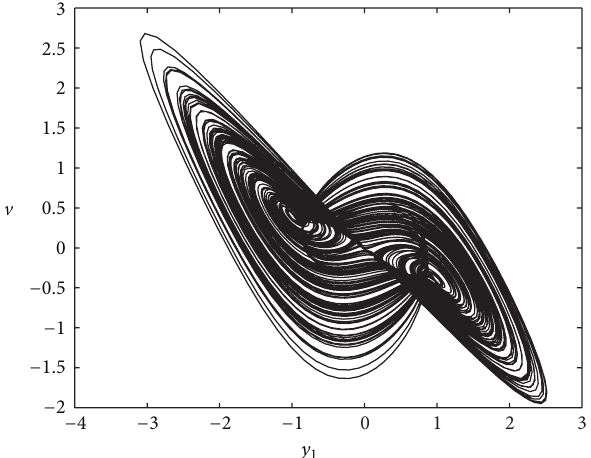
Figure 3: 𝑦 1 - V phase plane, the chaotic